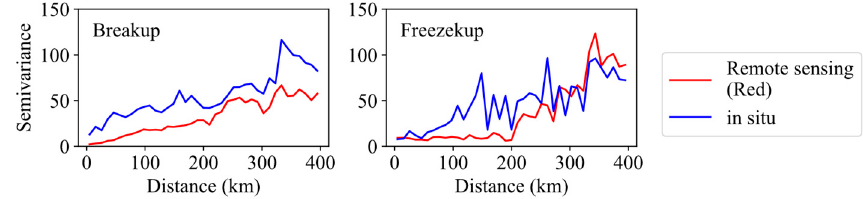
Figure 9. Semivariogram of breakup and freezeup dates in 2017.